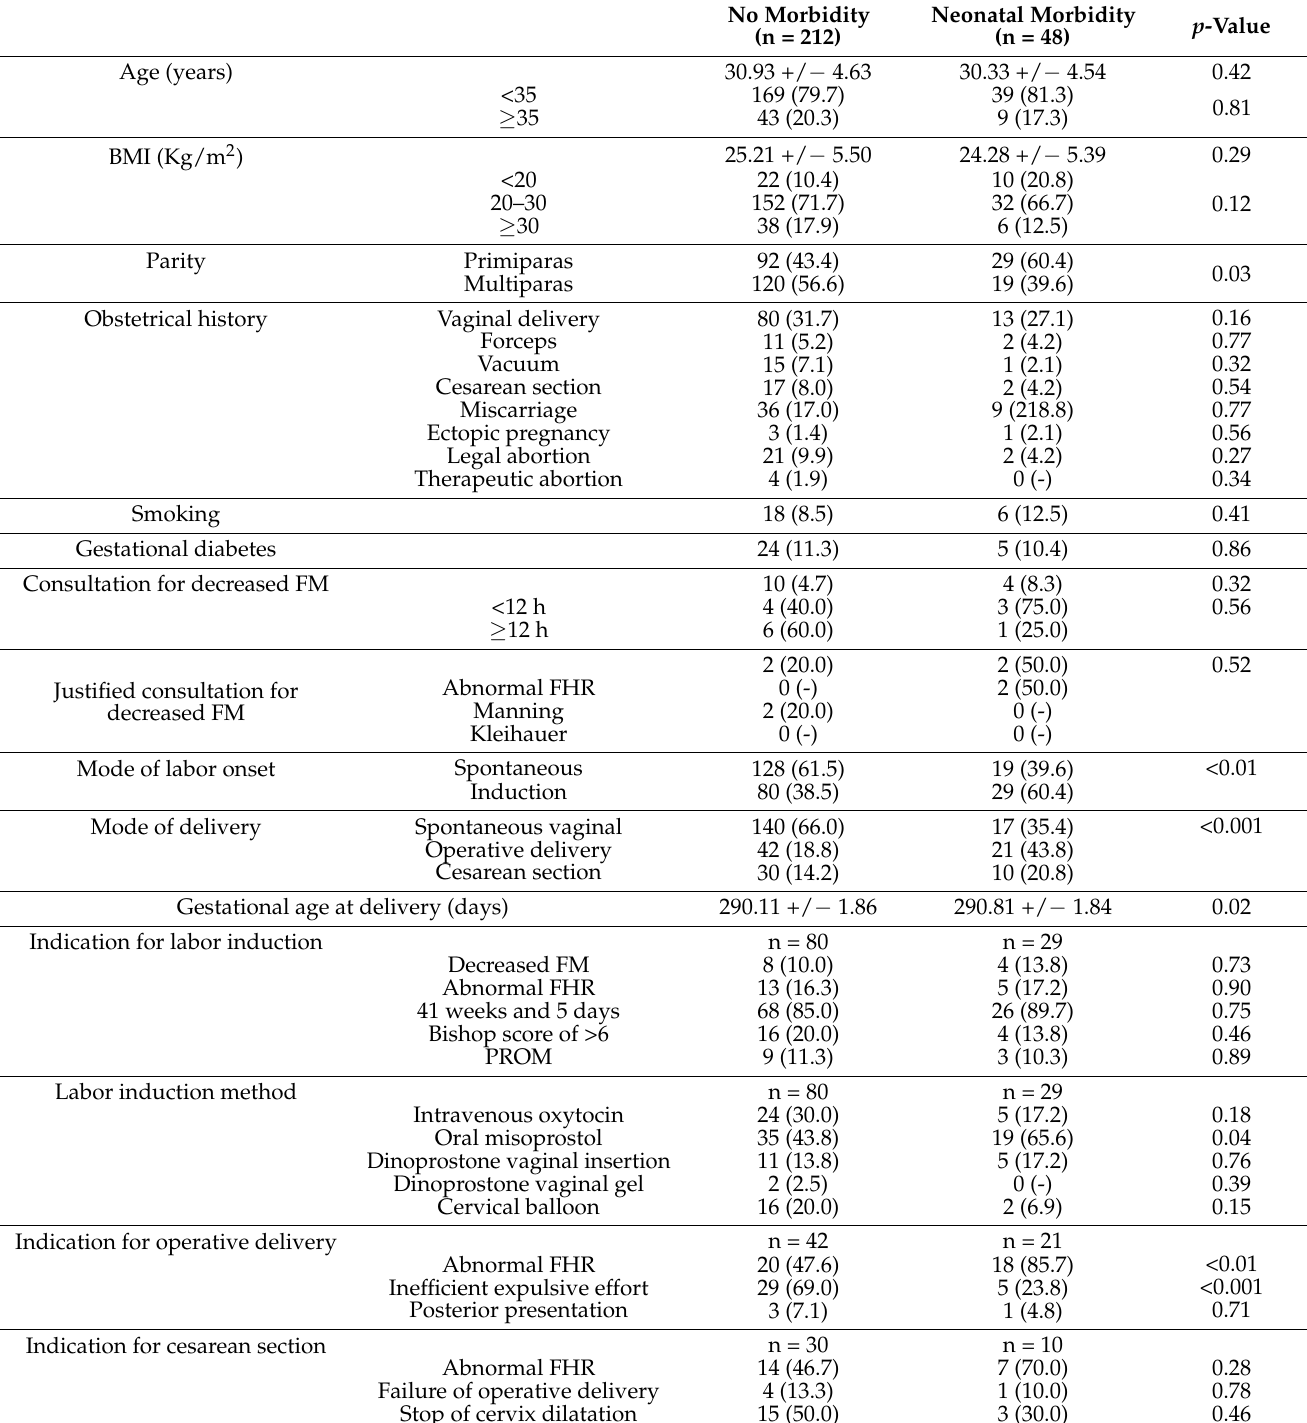
Table 5. Factors influencing the primary outcome. Data are expressed as n (%) or means +/ − standard